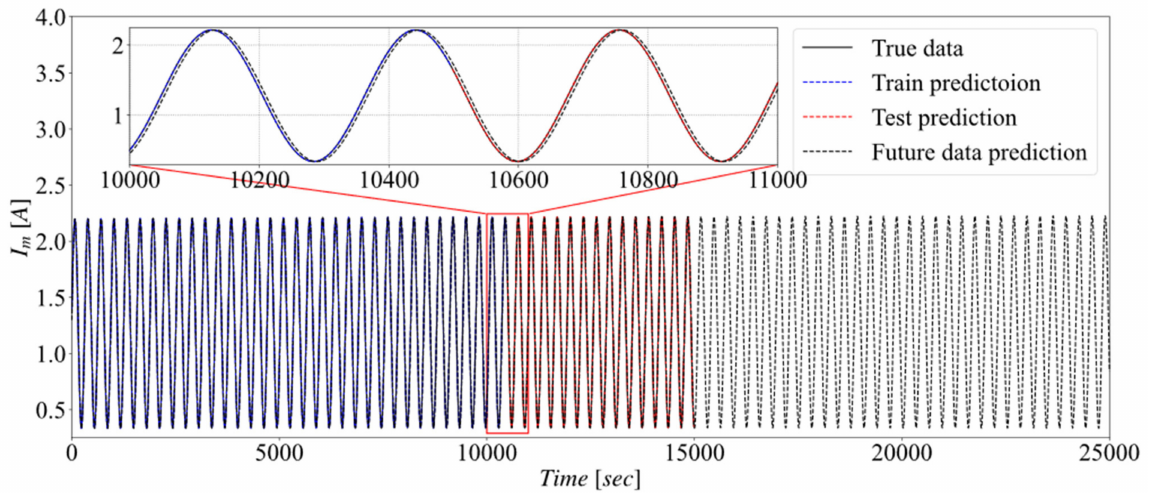
Figure 8. Prediction of motor current data.